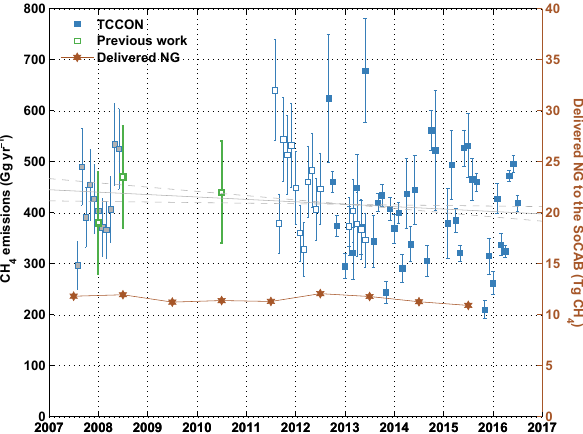
Figure 6. Natural gas, crude oil, and natural gas liquids production in the Los Angeles Basin, reported by USEIA (2015c, a, b), are shown in the top panel. The natural gas liquids production values are multiplied by 5 for scale. In the lower panel, the production is scaled to illustrate the changes in production relative to 2000. The MkIV C 2 H 6 emissions relative to 2000 (black circles) are added for